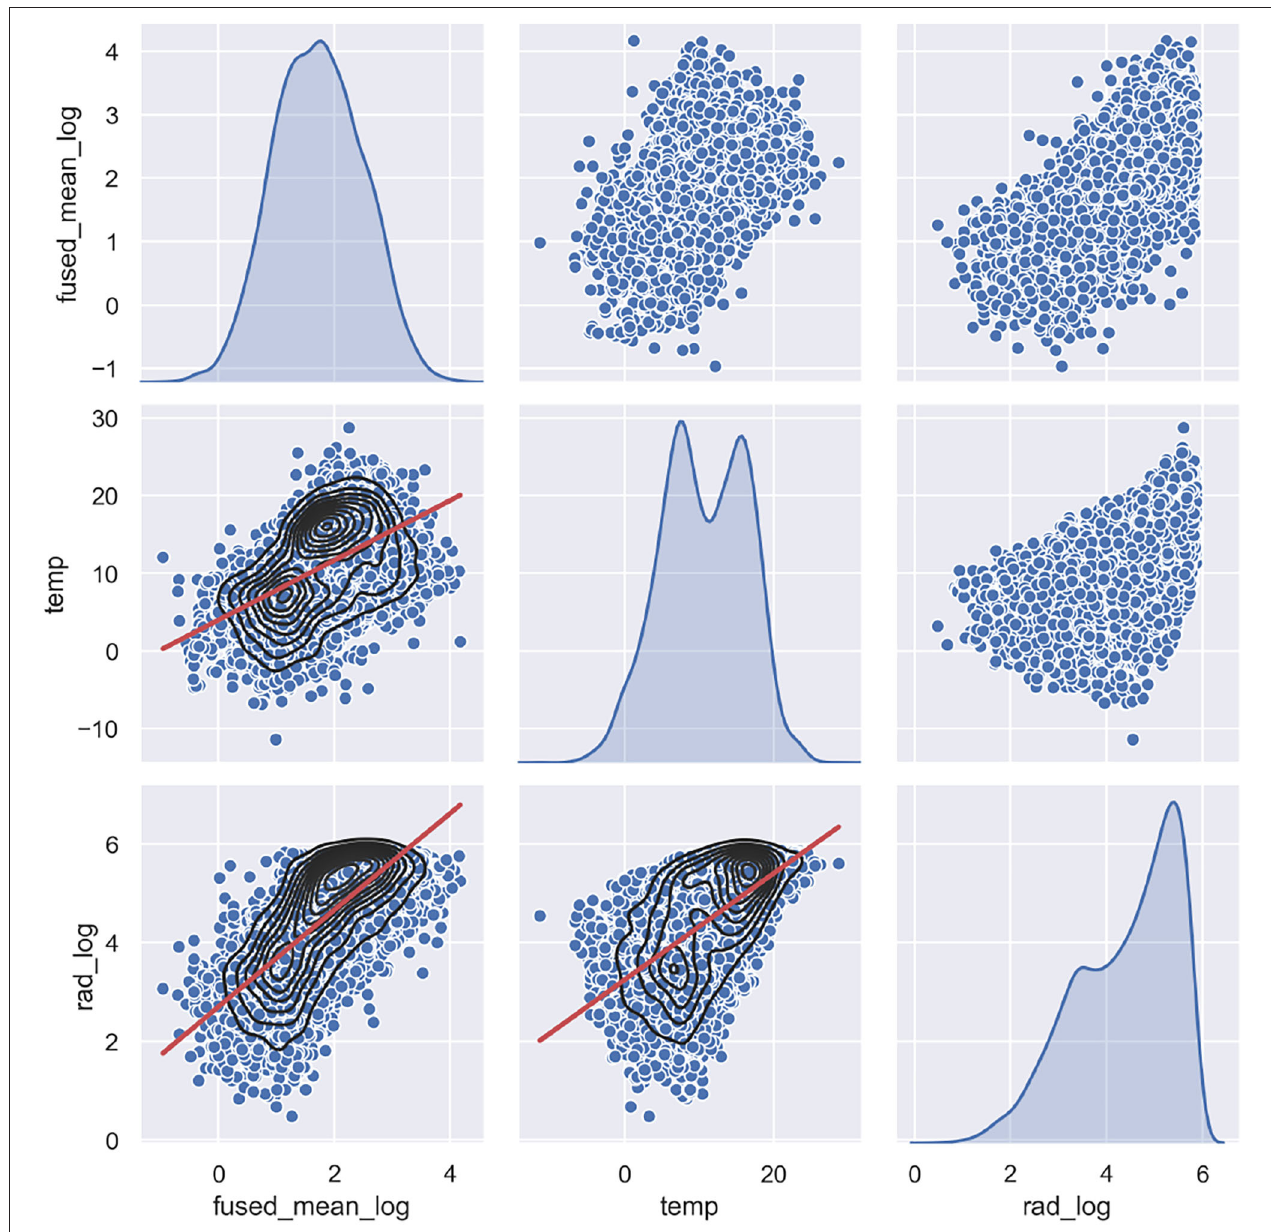
FIGURE 6 | Pair plots of the log transformed response variable (fused chlorophyll-a), and the explanatory variables (log transformed radiation and temperature). Scatter plots are shown together with Kernel Density Estimates (black) and linear regression (red).